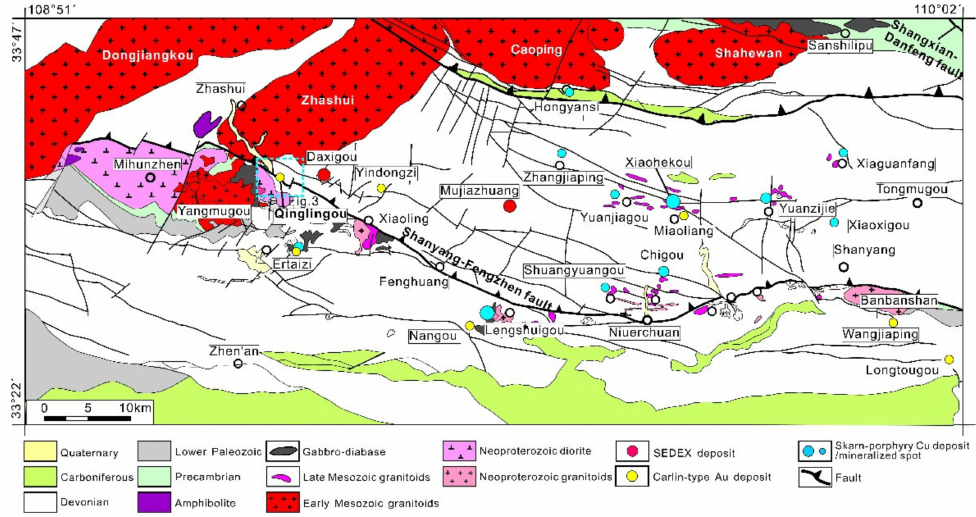
Figure 2. Geological map of the Zhashui-Shanyang ore district cluster showing the distribution of granitoids and deposits